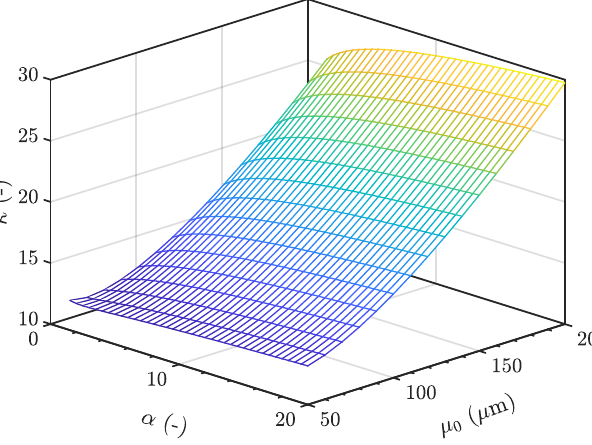
Figure 15. Weibull factor κ depending on the return period α and the local defect population µ 0 .